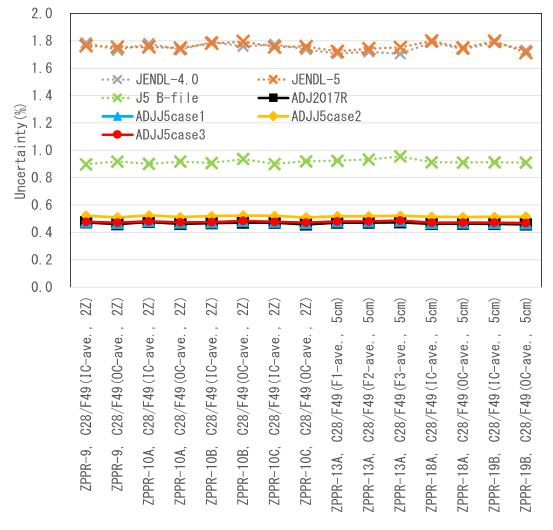
Figure 6. Nuclear-data-induced uncertainty of reaction rate ratio of C28 / F49